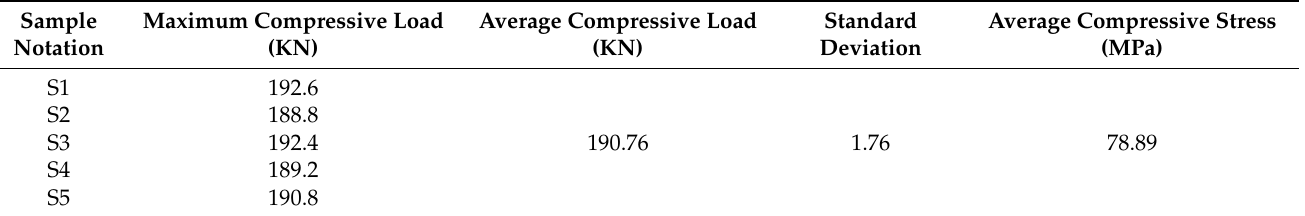
Table 1. Compressive tests results.